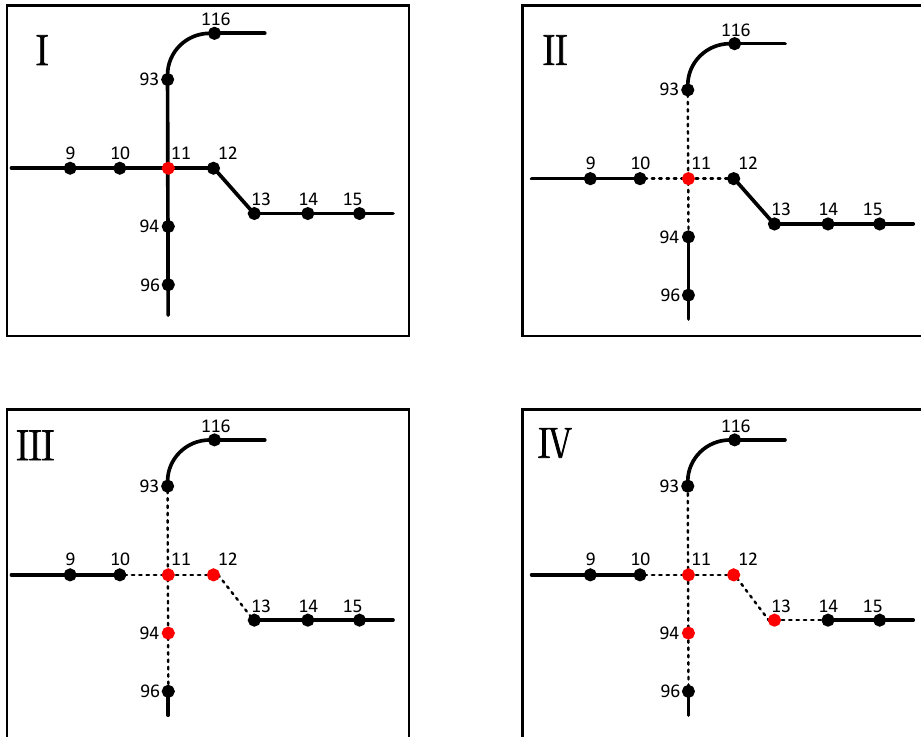
Figure 9. Network cascading failure caused by node 11 failure.